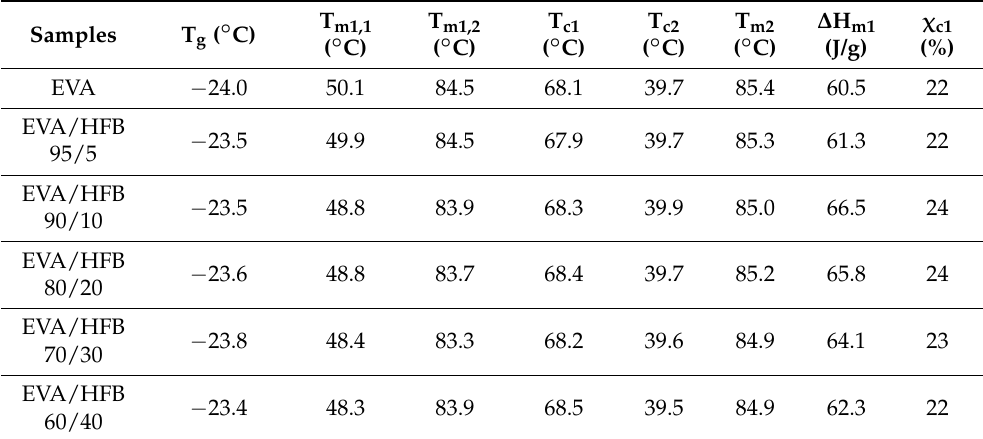
Table 1. Thermal parameters of EVA and EVA composites.